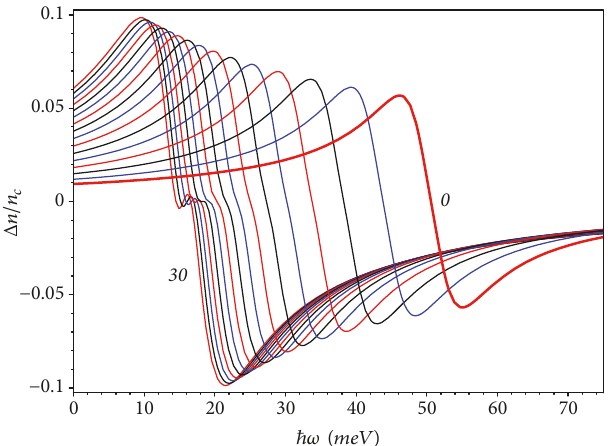
Figure 5: CRI as a function of the photon energy in a cylindrical nanowire of radius 𝑅 = 100 ˚A with an inverse parabolic potential of values from ℎ𝜔 0 = 0 𝑚𝑒𝑉 (thickplot marked 0) to ℎ𝜔 0 = 30 𝑚𝑒𝑉 (plot marked 30)in incrementsof 2 𝑚𝑒𝑉 . Notethe almost parabolic enhancement of the magnitude of maxima (and minima) of the CRI as the inverse parabolic potential increases in strength.